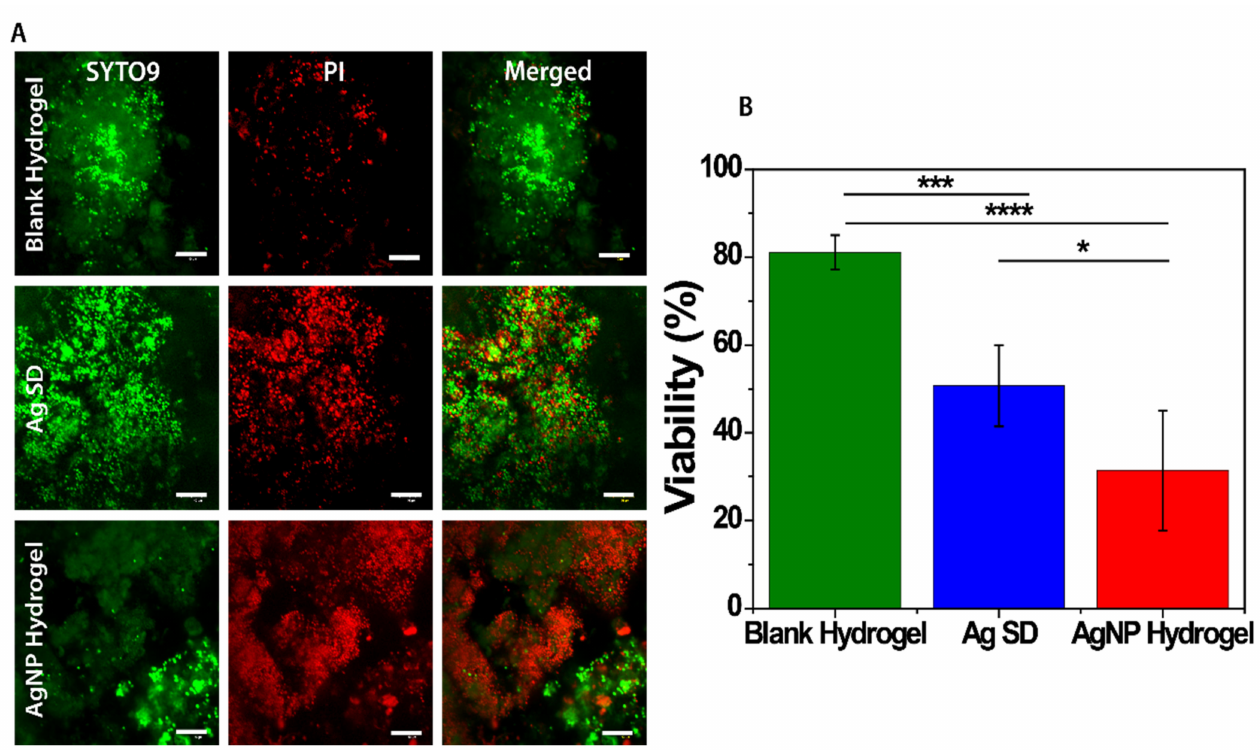
Figure 5. In vivo bacterial tissue biofilm staining and viability. ( A ) CLSM images of S. aureus bacteria showing the ratio of SYTO/PI in response to treatment with blank, Ag SD, and AgNP hydrogel treatments. ( B ) The corresponding cell viability of each treatment group. Data are shown as mean ± SD and the * denotes significant difference using one-way ANOVA followed by Dunnett’s multiple comparison test. * p < 0.05, *** p < 0.001 and **** p < 0.0001, Scale bar 10 µ m, n =